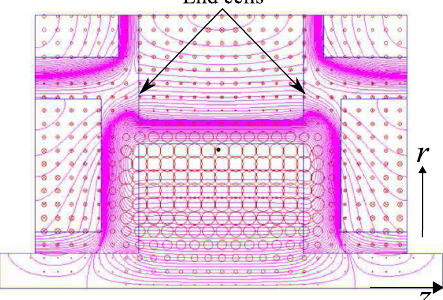
FIG. 8. Field distribution of an optimized single cell DAA cavity. Red lines indicate the electric lines of force. The circle symbols indicate the axisymmetric magnetic field of accelerating mode and the sizes of the circles represent the magnetic field strength.